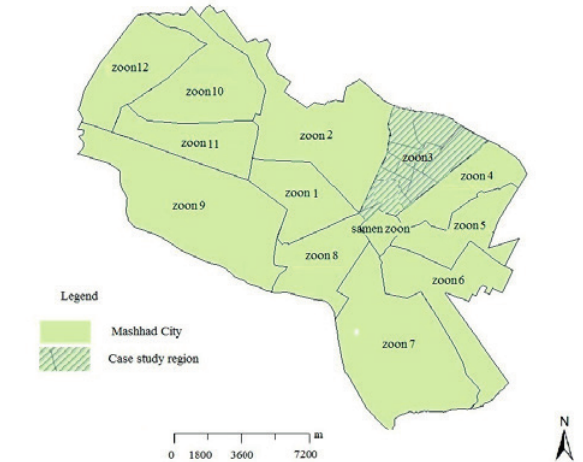
Fig. 1. The districts of